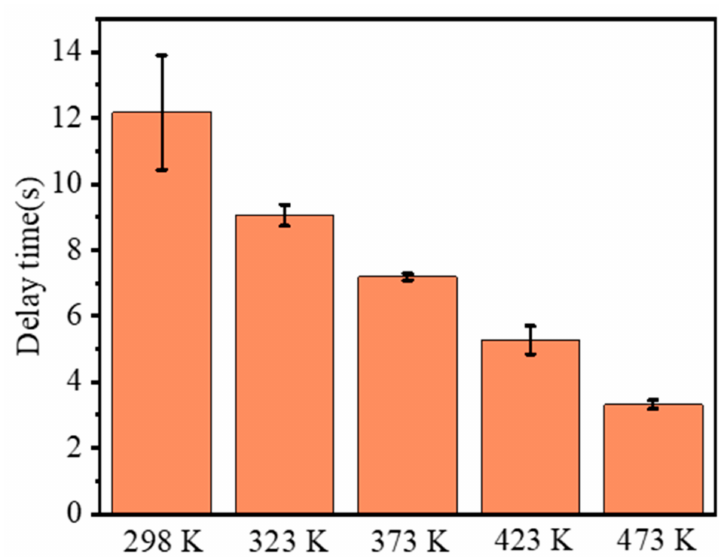
Figure 6. Comparison of ignition delay times at different initial